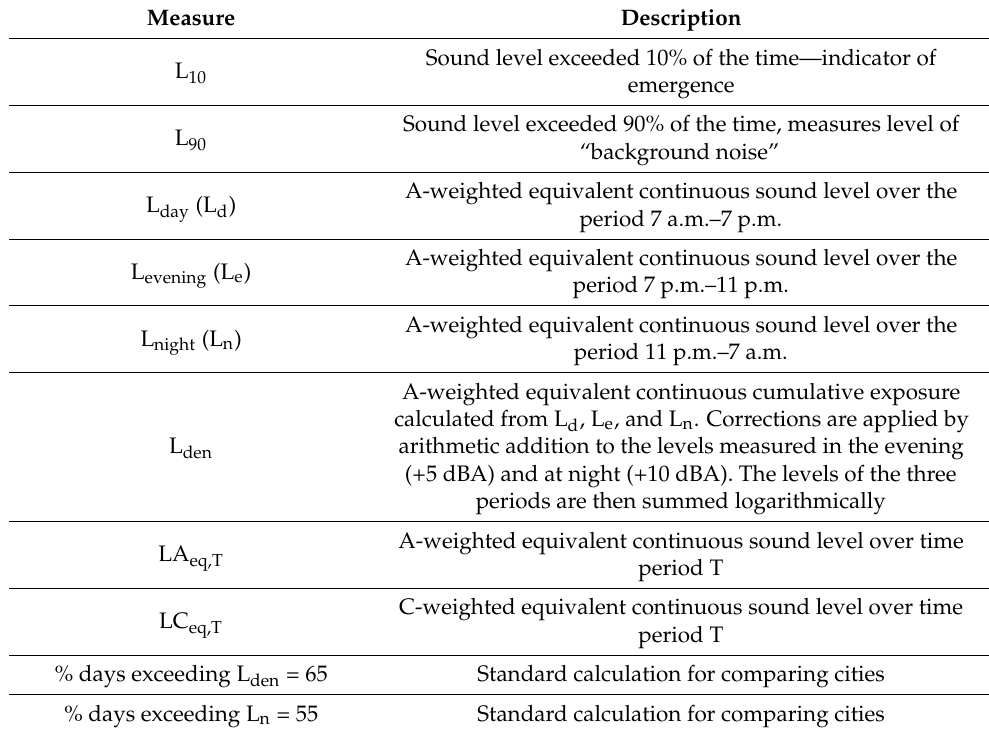
Table 1. We use the following indicators to characterize the sound